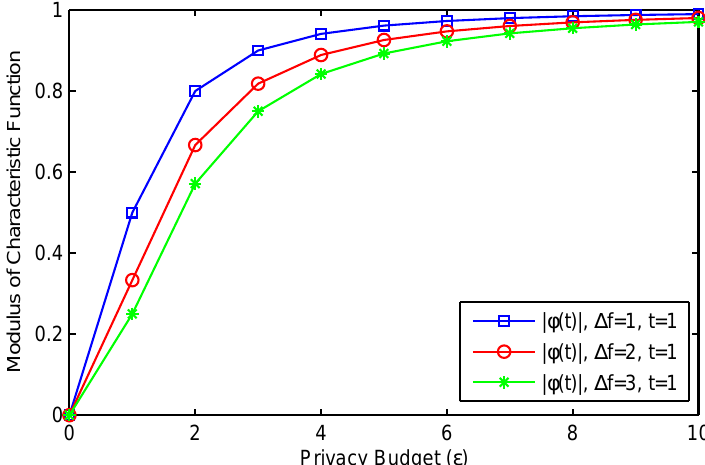
Figure 4. Modulus of characteristic function of query results of Laplace mechanism.